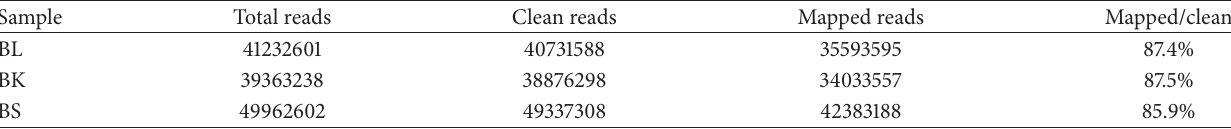
Table 1: Read number and mapping result from three independent libraries.